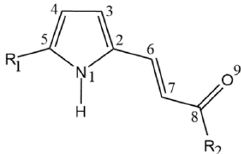
Scheme 4. Atom numbering for compounds 1 ( A ), 19 ( B ), and 37 ( C ).